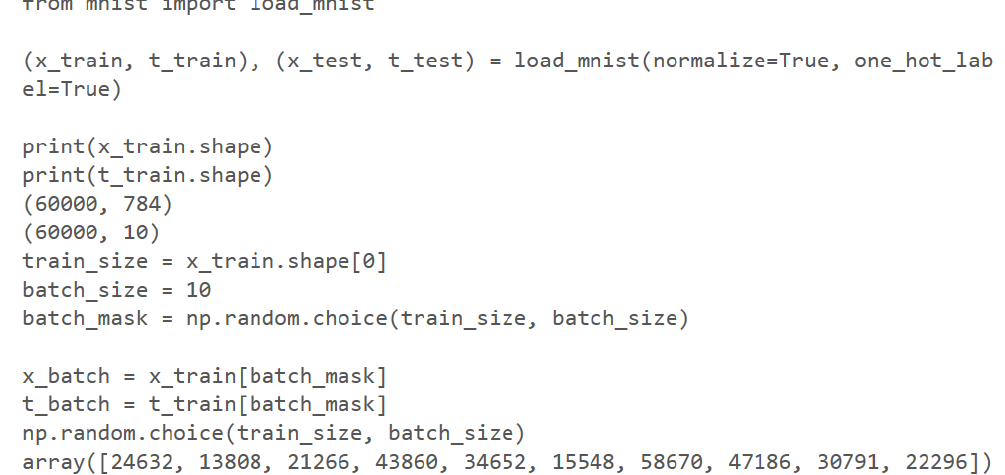
Figure 8. Source result for mini-batch learning.